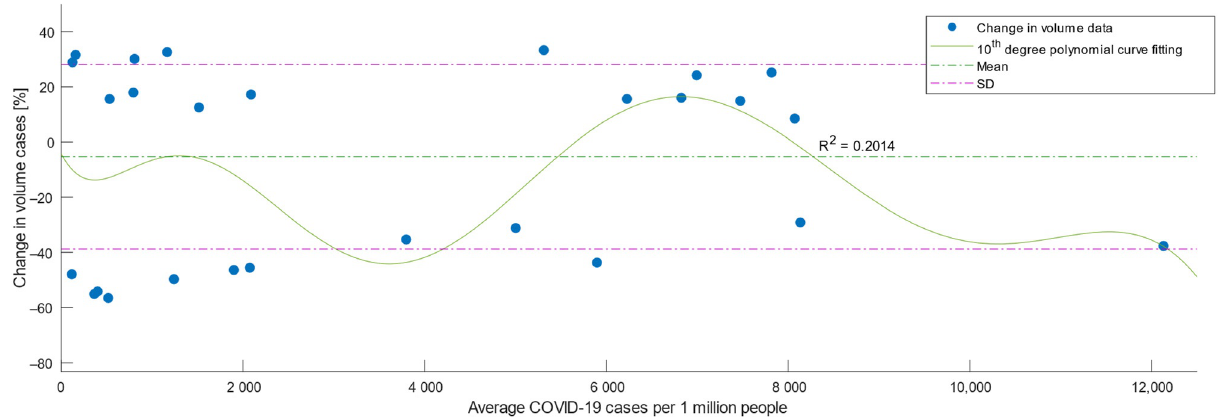
Figure 2. The scatterplot for variation of elective intervention volumes and the number of COVID-19 cases during the pandemic period in Romania. A polynomial curve fitting with an R square has been added to the scatterplot in order to show the correlation.